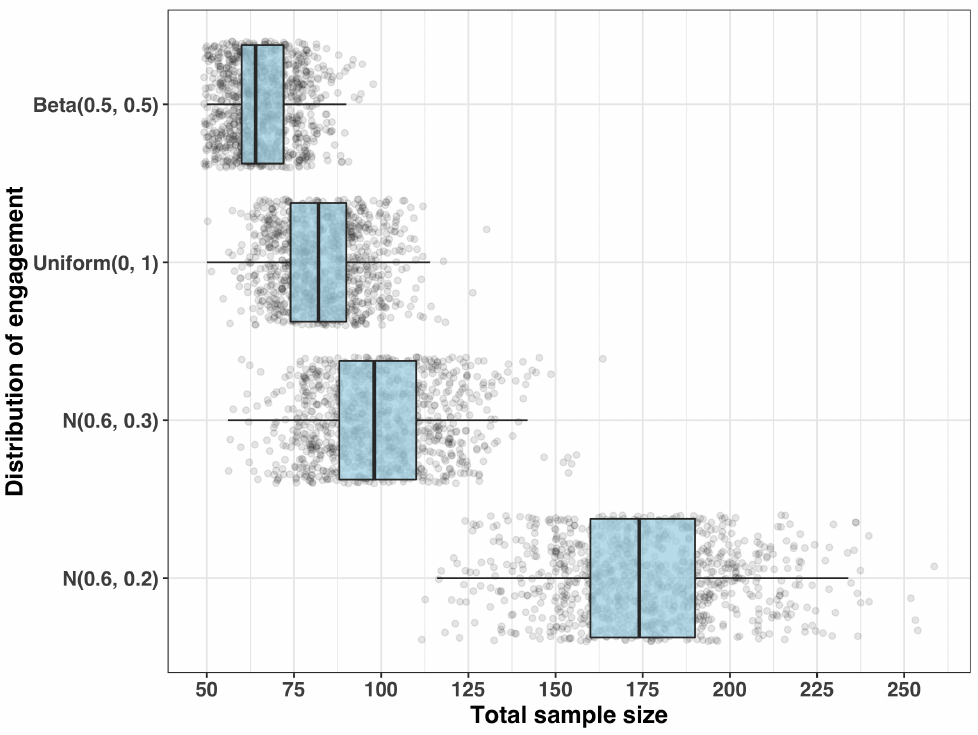
Figure 3. Distributions of the sample size to achieve 80% power of ANCOVA t -test of H 0 : ∆ 0 = 0 us- ing 2-sided α = 5%. Responses were simulated from model (1) with µ E = − 1, µ C = 0, γ = − 0.5, and σ = 1. Four different distributions of engagement were considered (top to bottom): Beta (0.5,0.5); Uni- form (0,1); Normal with mean = 0.6 and standard deviation (SD) = 0.3; and Normal with mean = 0.6 and SD =